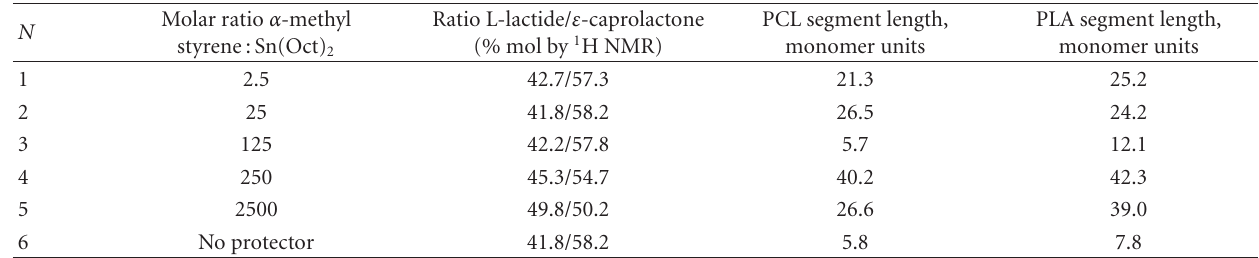
Table 3: NMR data of the structural analysis of triblock copolymers.